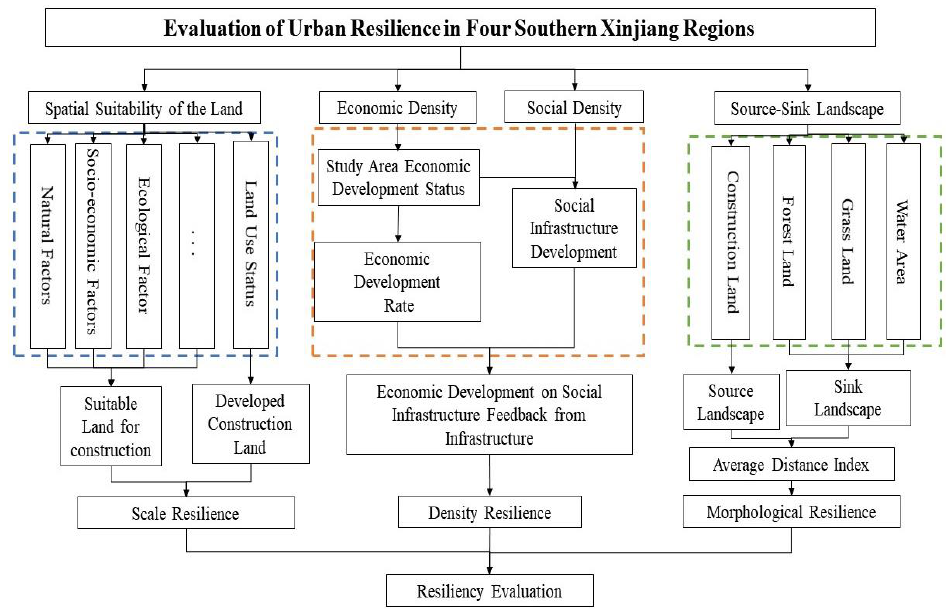
Figure 2. “ Scale-density-form ” urban resilience evaluation technology roadmap. Figure 2. “Scale-density-form” urban resilience evaluation technology roadmap.